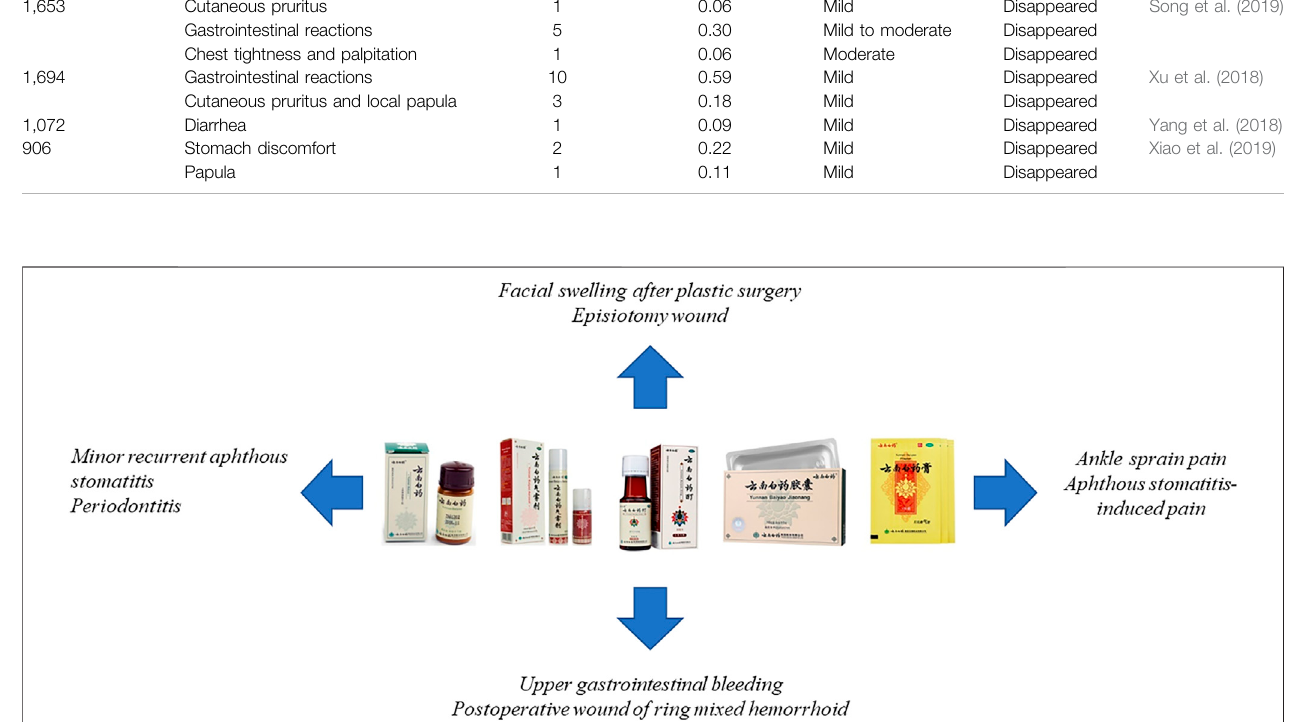
FIGURE 4 | Clinical applications of Yunnan Baiyao preparations marketed in